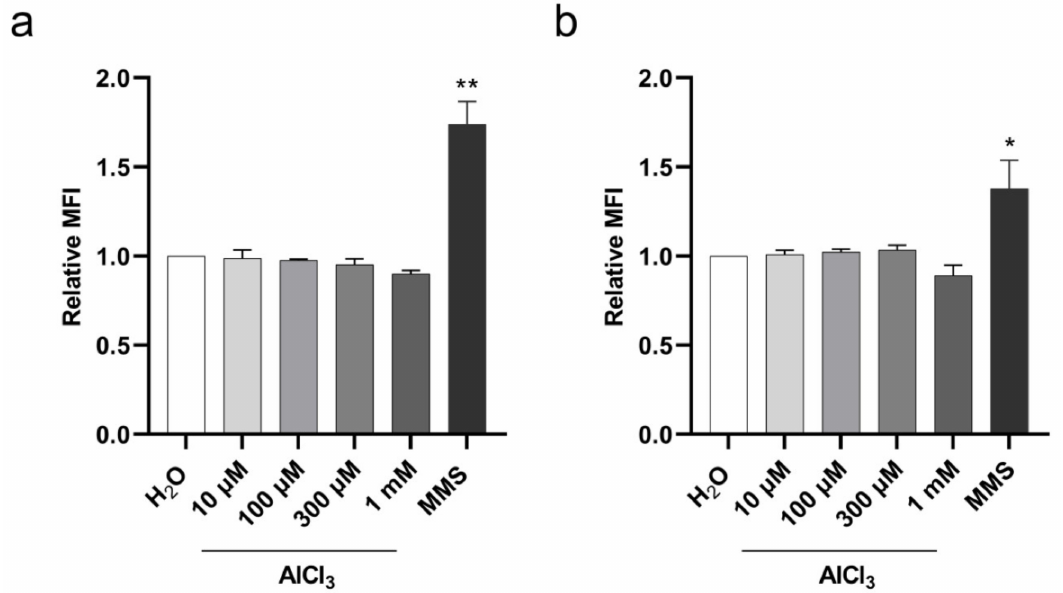
Figure 5. Histone H2AX Ser-139 phosphorylation in V79 cells upon aluminum exposure. The cells were incubated for 3 h with the indicated concentrations of AlCl 3 or the same volume of vehicle (H 2 O) in serum-free medium. The DNA alkylating agent MMS was used as positive control. γ -H2AX levels were measured by flow cytometry in G1 ( a ) and S ( b ) phase cell populations based on concurrent analysis of DNA content by DAPI staining. Bars represent the Relative Mean Fluorescence Intensity (MFI) (mean ± SEM) of four independent experiments. MFI values were expressed as the geometric mean values of the γ -H2AX fluorescence intensity signal of each population of control or treated cells in the G1 or S phase of the cell cycle. Relative MFI values were calculated as the ratio of MFI values of treated cells to the mean of MFI values of control cells. (*) p -value < 0.05; (**) p -value < 0.01 (Nested one-way ANOVA with Dunnett’s